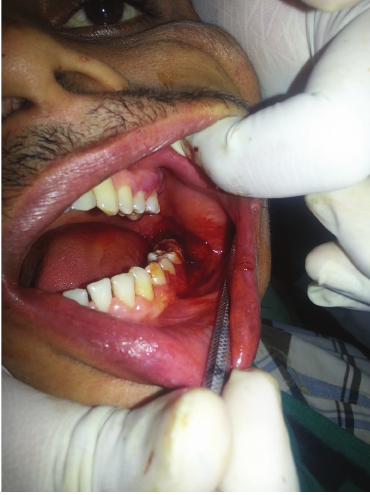
Figure 6: Operative (mandibular).